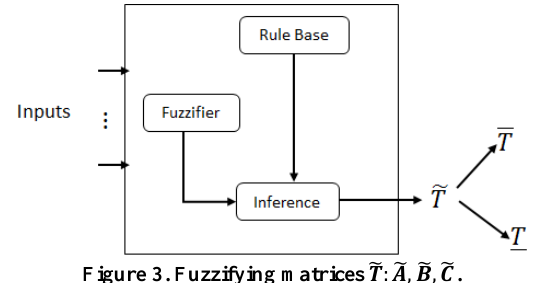
Figure 3. Fuzzifying matrices 𝑻̃:𝑨̃, 𝑩̃, 𝑪̃ .